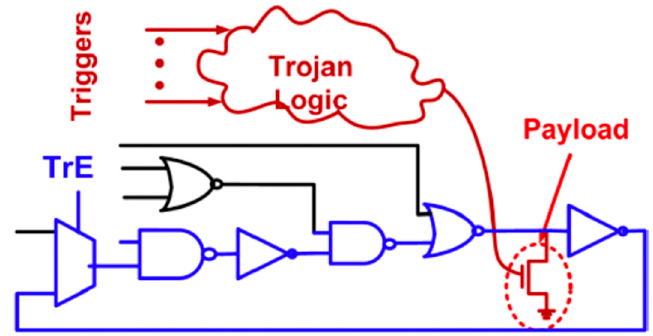
Figure 4. Payload insertion by-passing transistor payload [22].